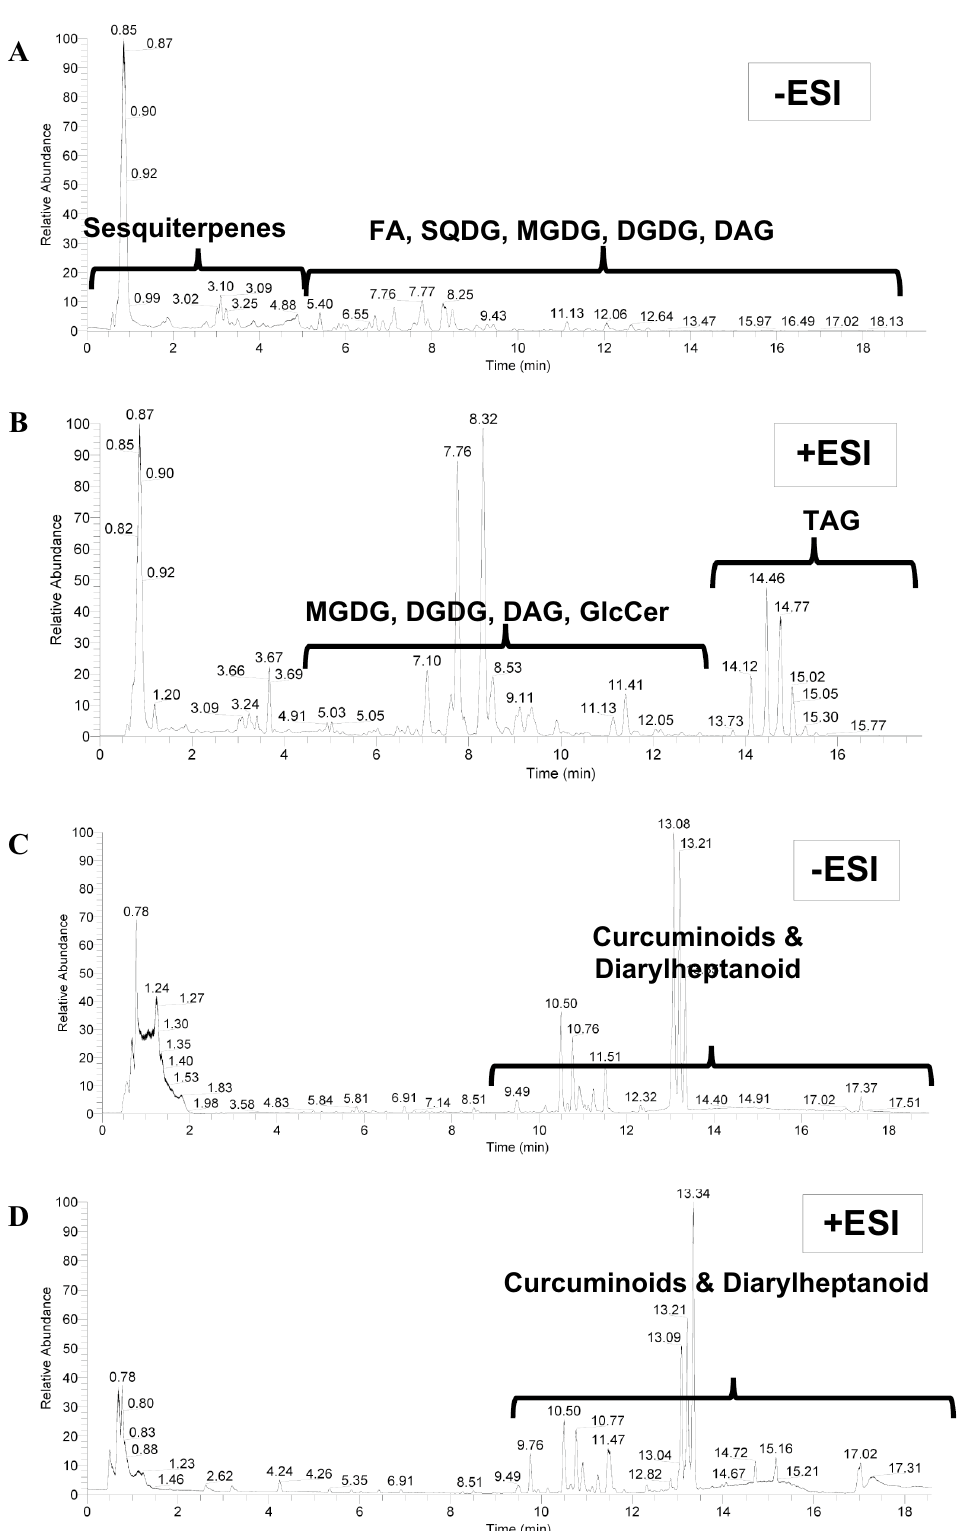
Figure 2. Total ion chromatograms of turmeric rhizome ( Curcuma longa L.) as analyzed by UPLC-C 8 -FT-MS/MS in negative ( A ) and positive ( B ) ionization modes, and UPLC-C 18 -FT-MS/MS in negative ( C ) and positive ( D ) ionization modes. Mass spectra were recorded in relative abundances of eluted peaks (y-axis) versus retention time in minutes (x-axis). The region of each eluted compounds class is indicated according to its elution window either in positive or negative ionization modes. DAG: diacylglyceride, DGDG: digalactosyldiacylglycerol, ESI: electrospray ionization, FA: fatty acid, GlcCer: glucosylceramide, MGDG: monogalactosyldiacylglycerol, SQDG: sulfoquinovosyldiacylglycerol, TAG: